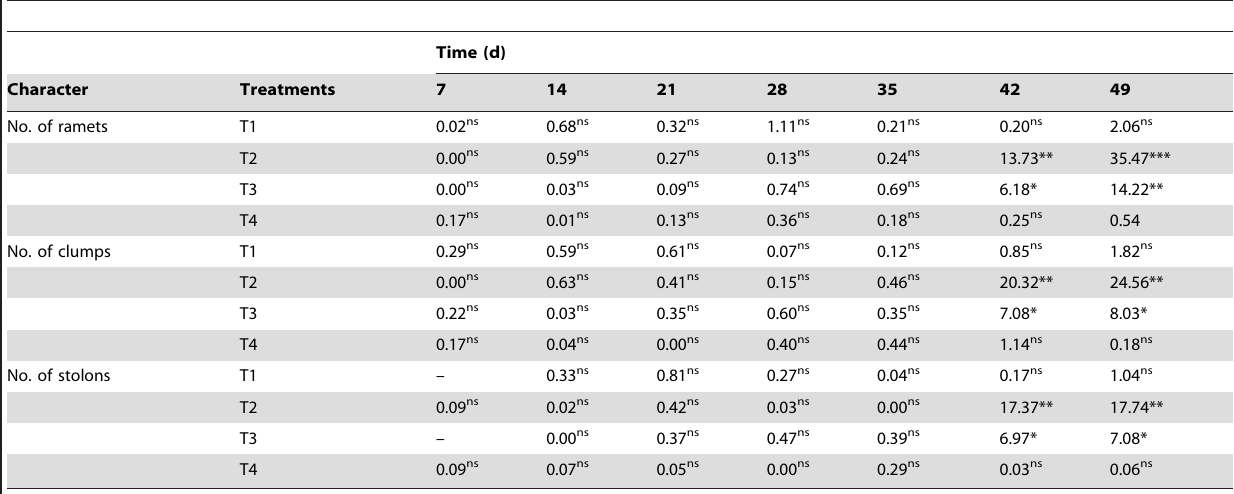
Table 2. Analysis of variance results of Buchloe dactyloides growth characters in different nutrient treatments on different days at clonal fragment level.